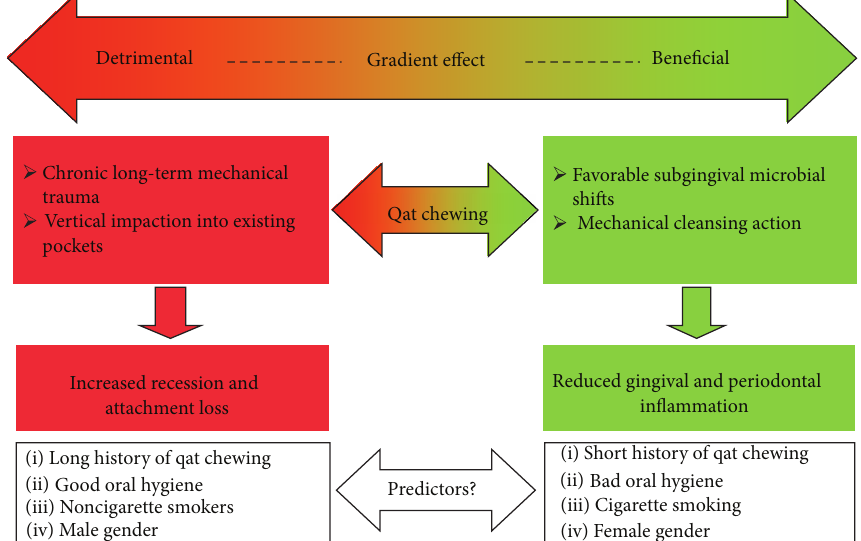
Figure 1: A holistic model for the effect of qat chewing on the